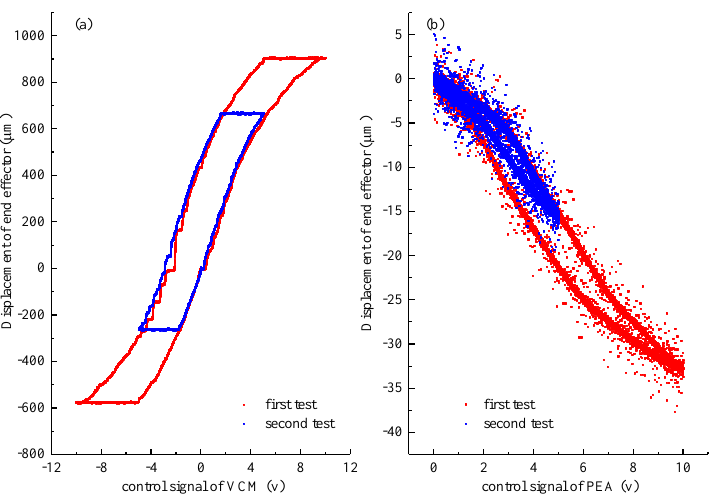
Figure 9. Stroke and hysteresis tests: ( a ) relationship between the displacement of the end effector and the control voltage of the VCM, ( b ) relationship between the displacement of the end effector and the control voltage of the PEA.